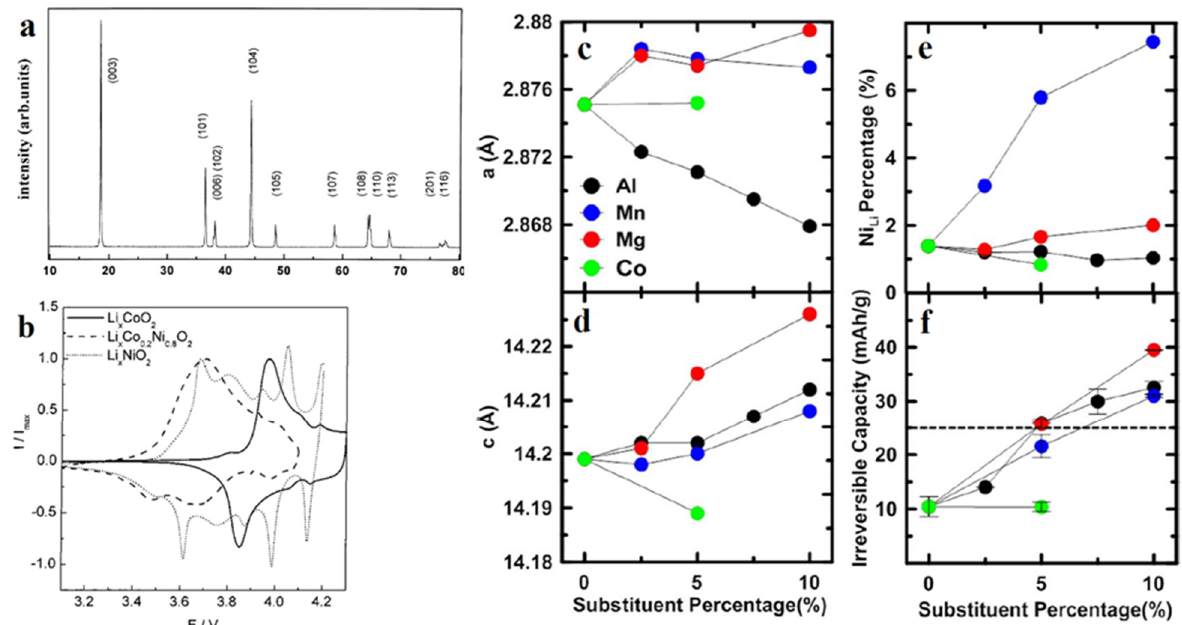
Figure 2. ( a ) XRD of LNO, reproduced with permission [32], ( b ) cyclic voltammetry of LCO-, LNO, and Co-doped LNO, reproduced with permission [24], ( c ) substituent percentage vs. a-axis, ( d ) substituent percentage vs. c axis, ( e ) substituent percentage vs. Ni Li , and ( f ) substituent percentage vs. irreversible capacity [8].